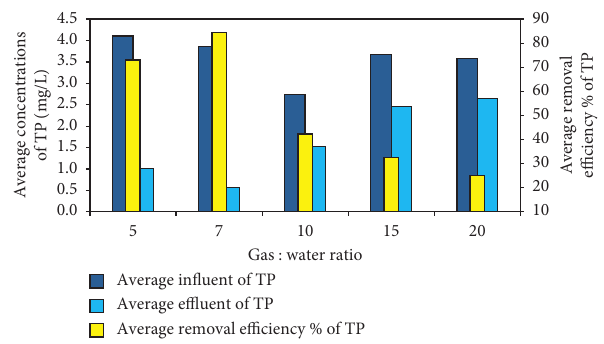
Figure 10: Effect of gas: water ratio on the average TP removal.